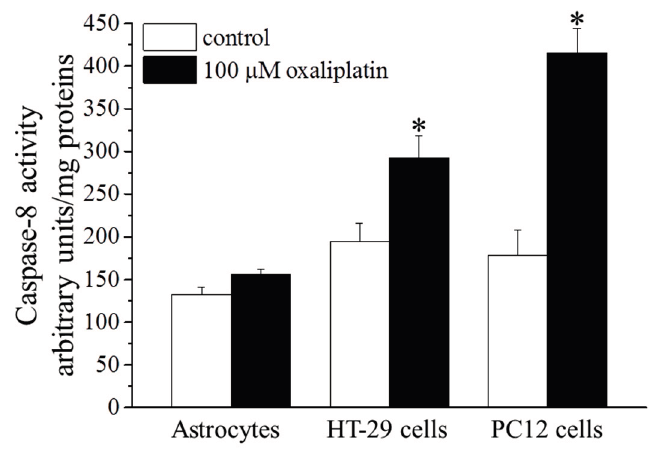
Figure 5. Caspase-8 activity. Astrocytes (5 × 10 5 cells/well), HT-29 (3 × 10 5 cells/well) and PC12 (3 × 10 5 cells/well) were treated with 100 μ M oxaliplatin for 8 h. Caspase-8 activity was expressed as fluorescent arbitrary unit/mg protein. Bars represent the mean ± S.E.M. of three experiments. * p < 0.05 vs. control.